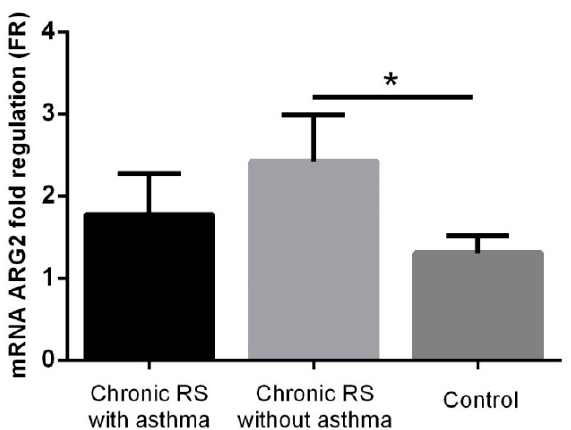
Figure 4. ARG2 expression in the group with chronic rhinosinusitis (with or without allergy) and in the control group. ** p<0.005.